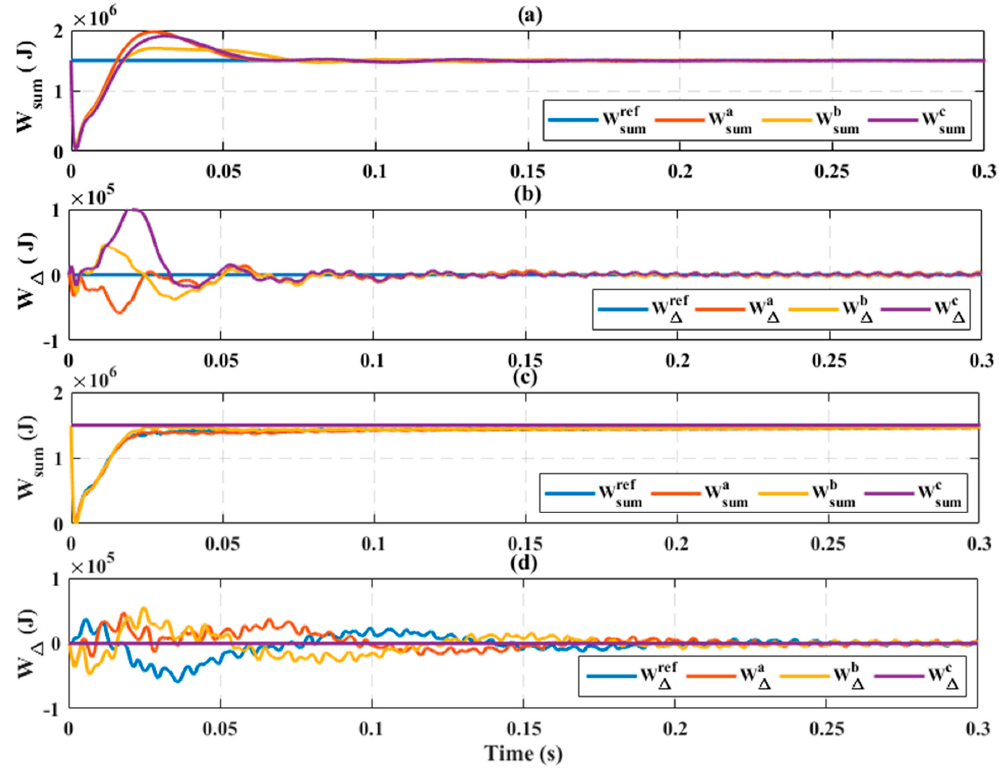
Figure 14 . ( a ) Energy sum control with SMC; ( b ) energy difference with SMC; ( c ) energy sum with PR; ( d ) energy difference with PR . ( d ) energy di ff erence with